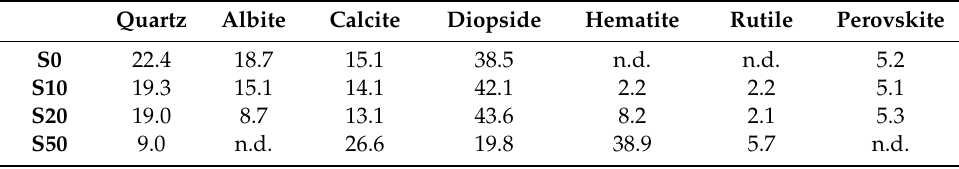
Table 3. Quantitative (wt%) mineralogical composition of coated ceramics.